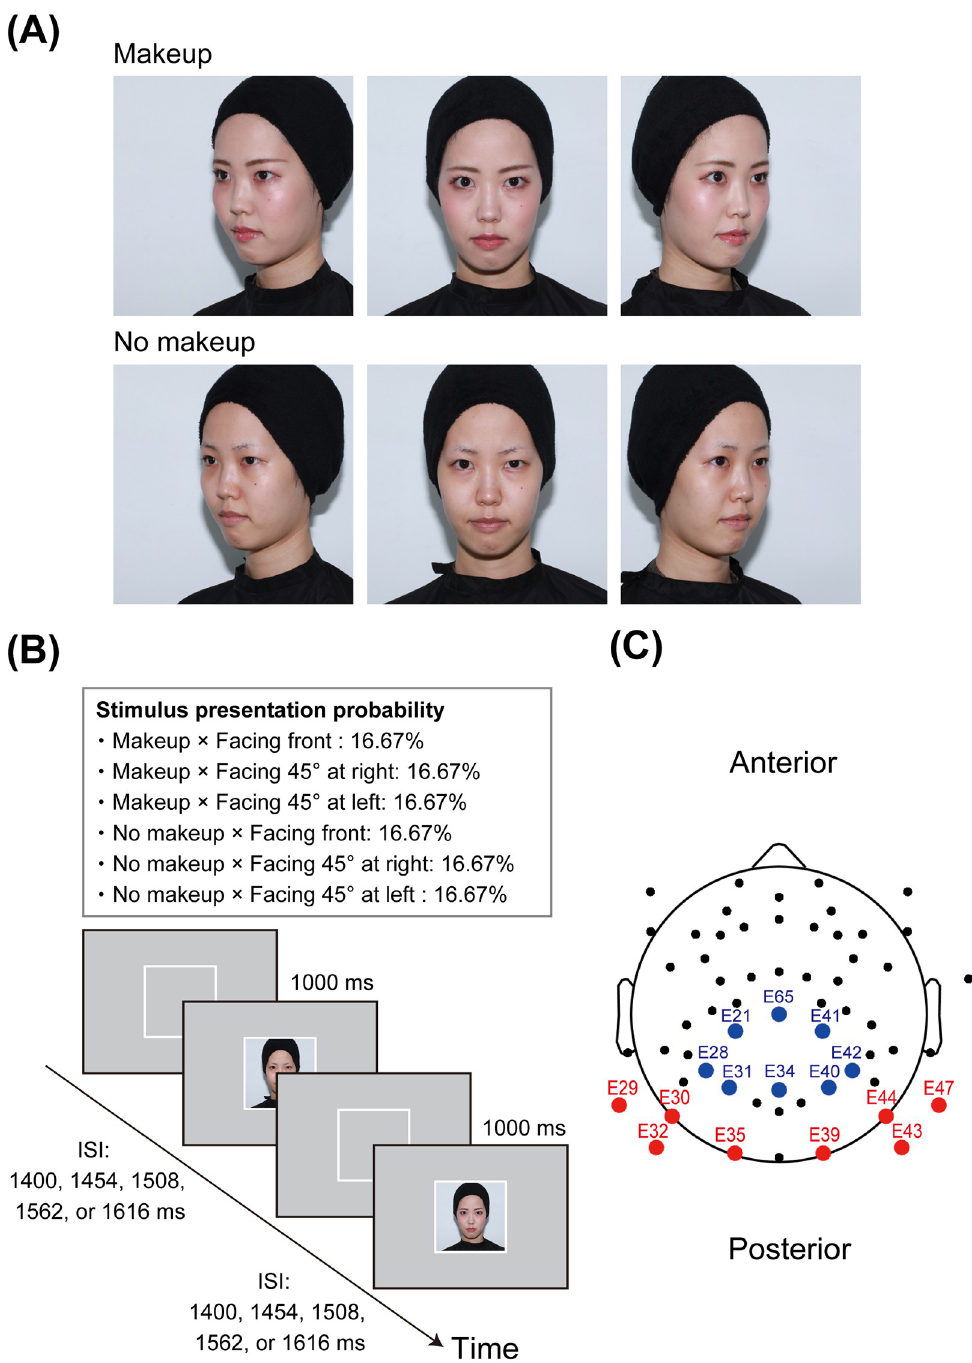
Fig 1. Stimuli and procedures in Experiment 1. Panel A depicts an example of facial images. The individual in this figure has given written informed consent to publish her facial images. Panel B illustrates a schematic representation of the makeup identification task. Panel C shows the EEG sensor layout and ROIs. The electrodes included in the occipitotemporal ROI are marked in red, and the blue circles indicate electrodes located in the centroparietal ROI. EEG, electroencephalogram; ROI, region of